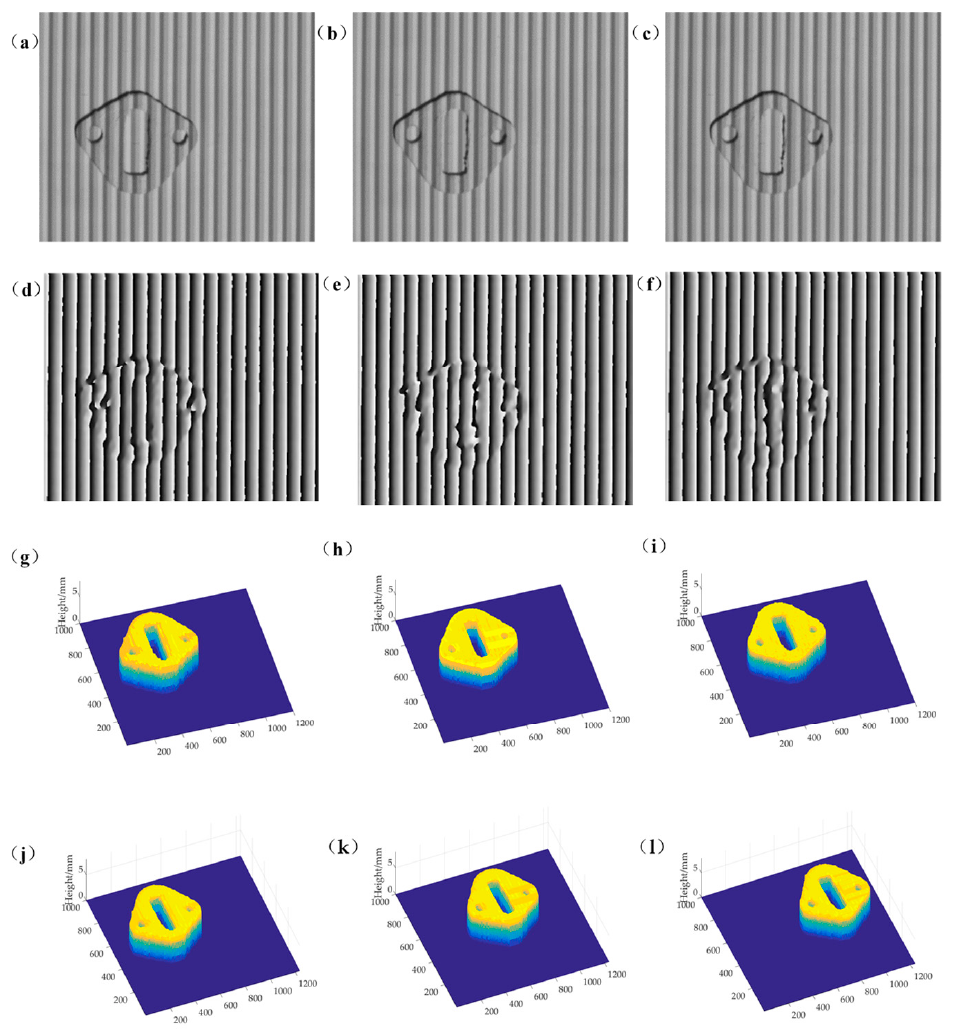
Figure 10. Real-time experiment for the workpiece: ( a – c ) the four grayscale deformed patterns captured online; ( d – f ) the corresponding wrapped phases; ( g – i ) the corresponding reconstructed results in high speed; and ( j – l ) the reconstructed results in lower shutter speed.